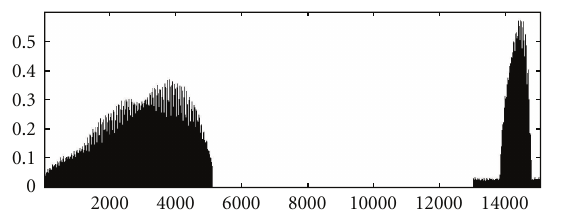
Figure 8: Integrated SSOCT signals obtained from two swept sources.